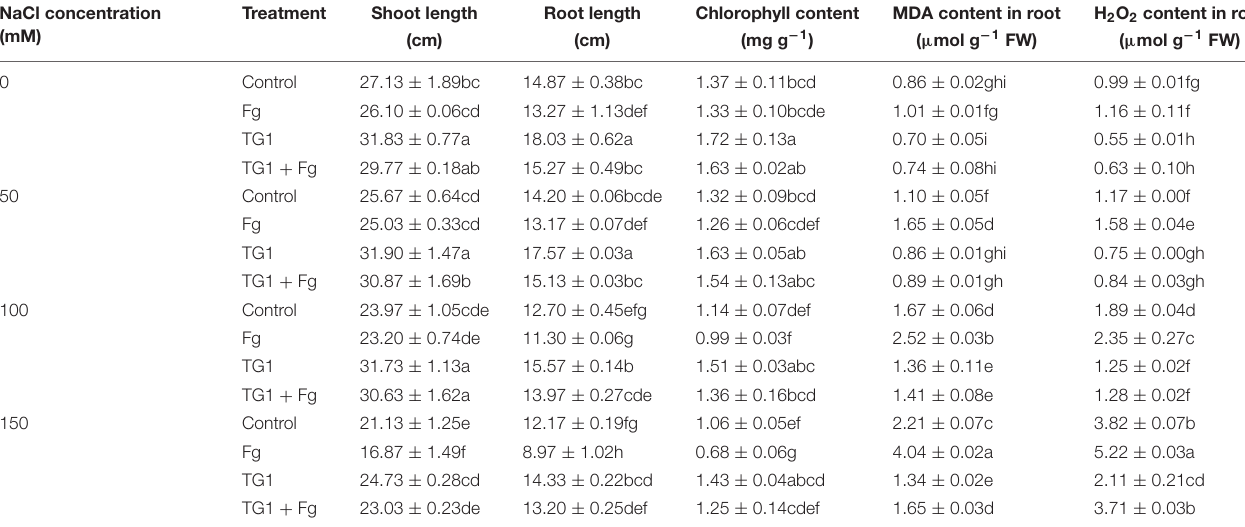
TABLE 2 | Effect of T. longibrachiatum (TG1) on wheat seedlings growth, chlorophyll content and ROS accumulation under F. pseudograminearum (Fg) and different salt stresses. NaCl concentration